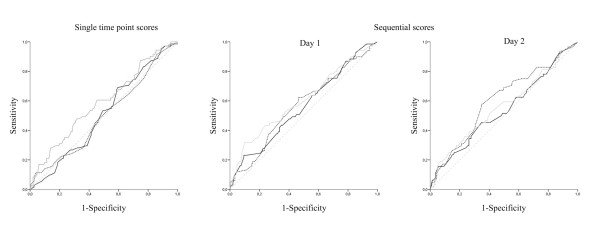
Receiver operating characteristic (ROC) curves associated with the area under the curves depicted in Table 3. ROC's are displayed for the scoring systems measured at a single time point (APACHE-II(), SAPS-II(), MPI() compared to the reference line ()) and for sequential scoring systems (MODS(), SOFA(), APS() compared to the reference line ()) measured at day 1 and at day 2.